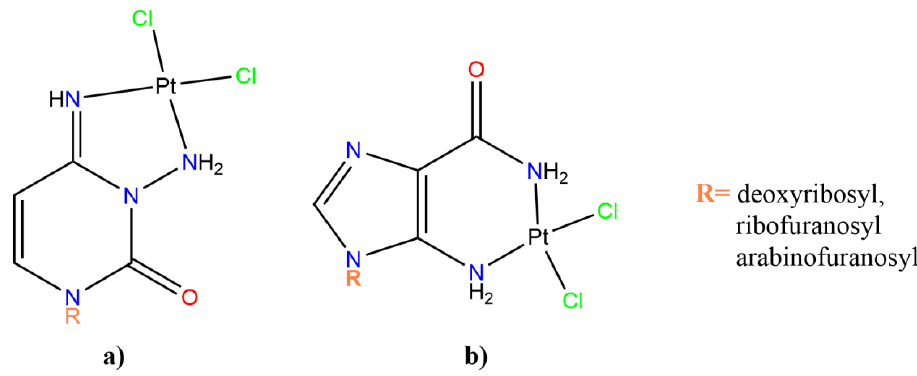
Figure 5. Schematic representation of the cis -dichloridoplatinum(II)- N -aminated nucleoside complexes. ( a ) Pt-cytosine analogues; ( b ) Pt-guanosine-like derivatives. R = deoxyribosyl, ribofuranosyl, arabinofuranosyl.